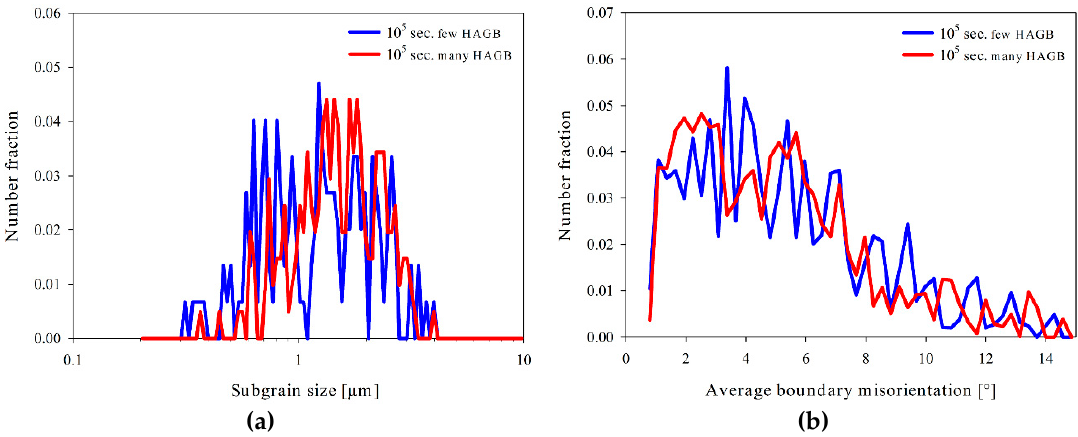
Figure 15. Comparison of size ( a ) and average boundary misorientation ( b ) distributions of subgrains with Cu orientation in CP Al after annealing for 10 5 s at 250 °C. The average subgrain size of the HAGB case is 16% larger and has 5 times as many high-angle grain boundaries.